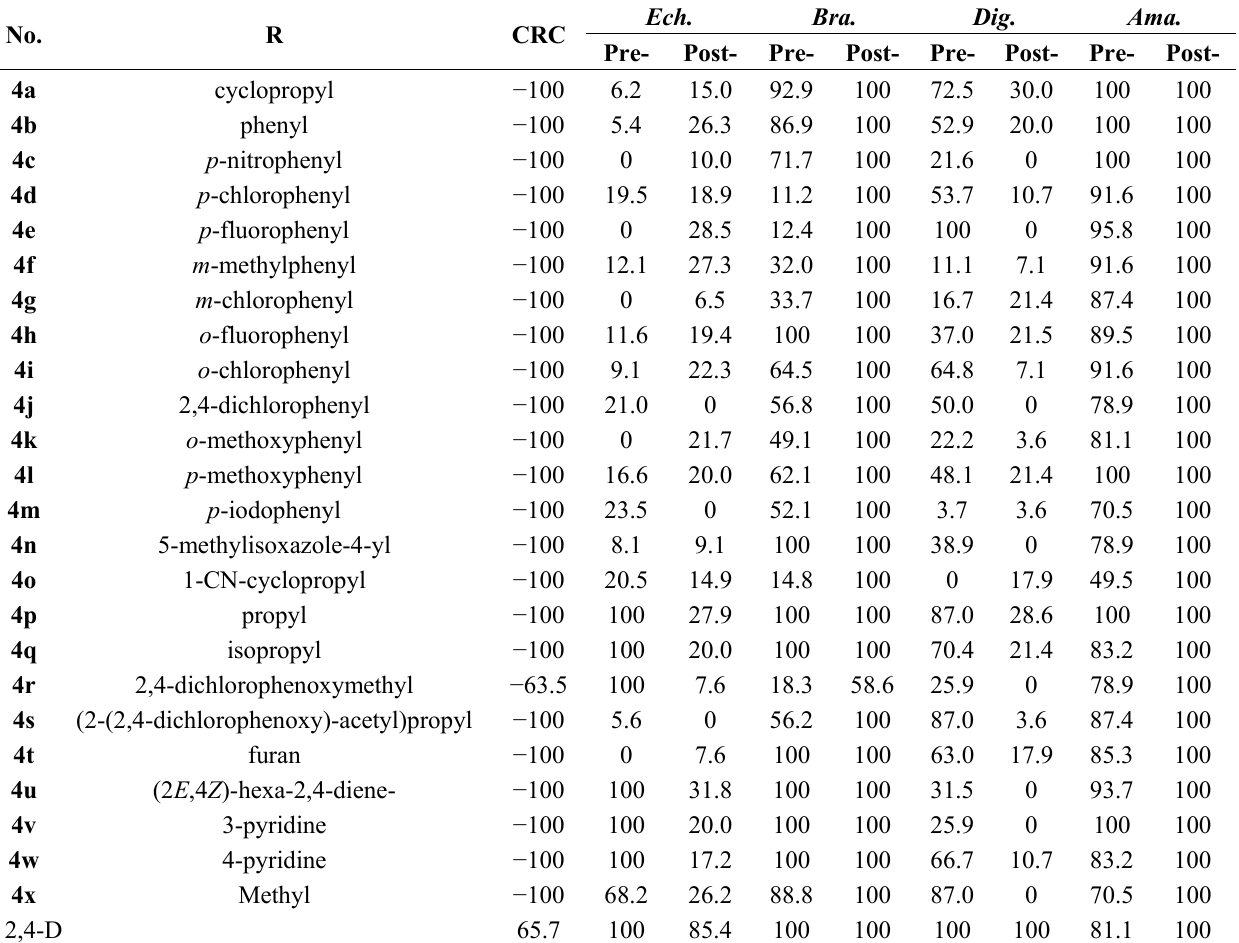
Table 2. The herbicidal c and plant growth regulatory c activity of title compounds.